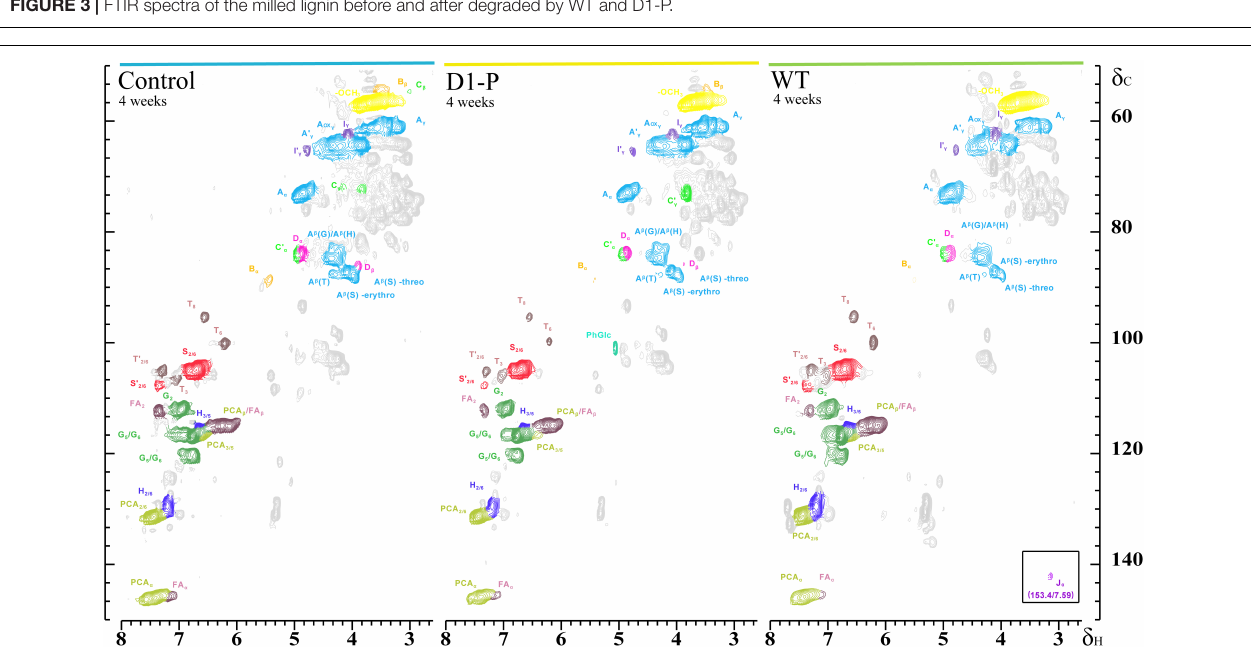
FIGURE 3 | FTIR spectra of the milled lignin before and after degraded by WT and D1-P.